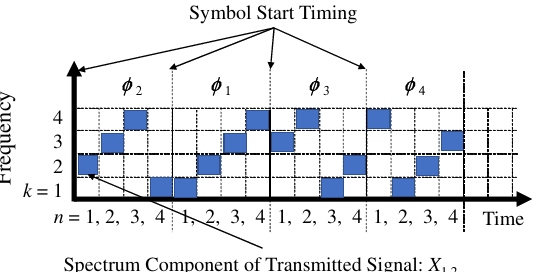
Figure 3. Frequency spectrum of chirp modulation in LoRa. Carrier frequency cyclically increases or